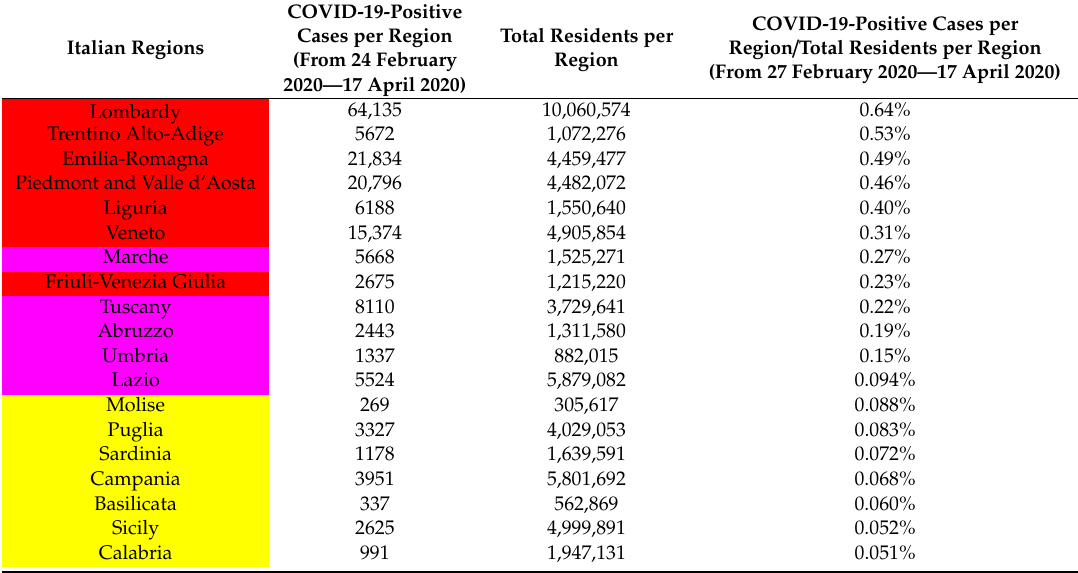
Table 1. First two columns: total COVID-19-positive cases (including recovered patients and deceased) in the time range 24 February–17 April 2020 and total population o ffi cially residing in each Italian region on 31 December 2019. Third column: COVID-19-positive cases per region / total residents per region. In red: Northern regions (NB: Piedmont, Lombardy, Emilia-Romagna, Veneto, Friuli-Venezia Giulia partly make up the Po Valley), in fuchsia: Central regions; in yellow: Southern / Island Regions.